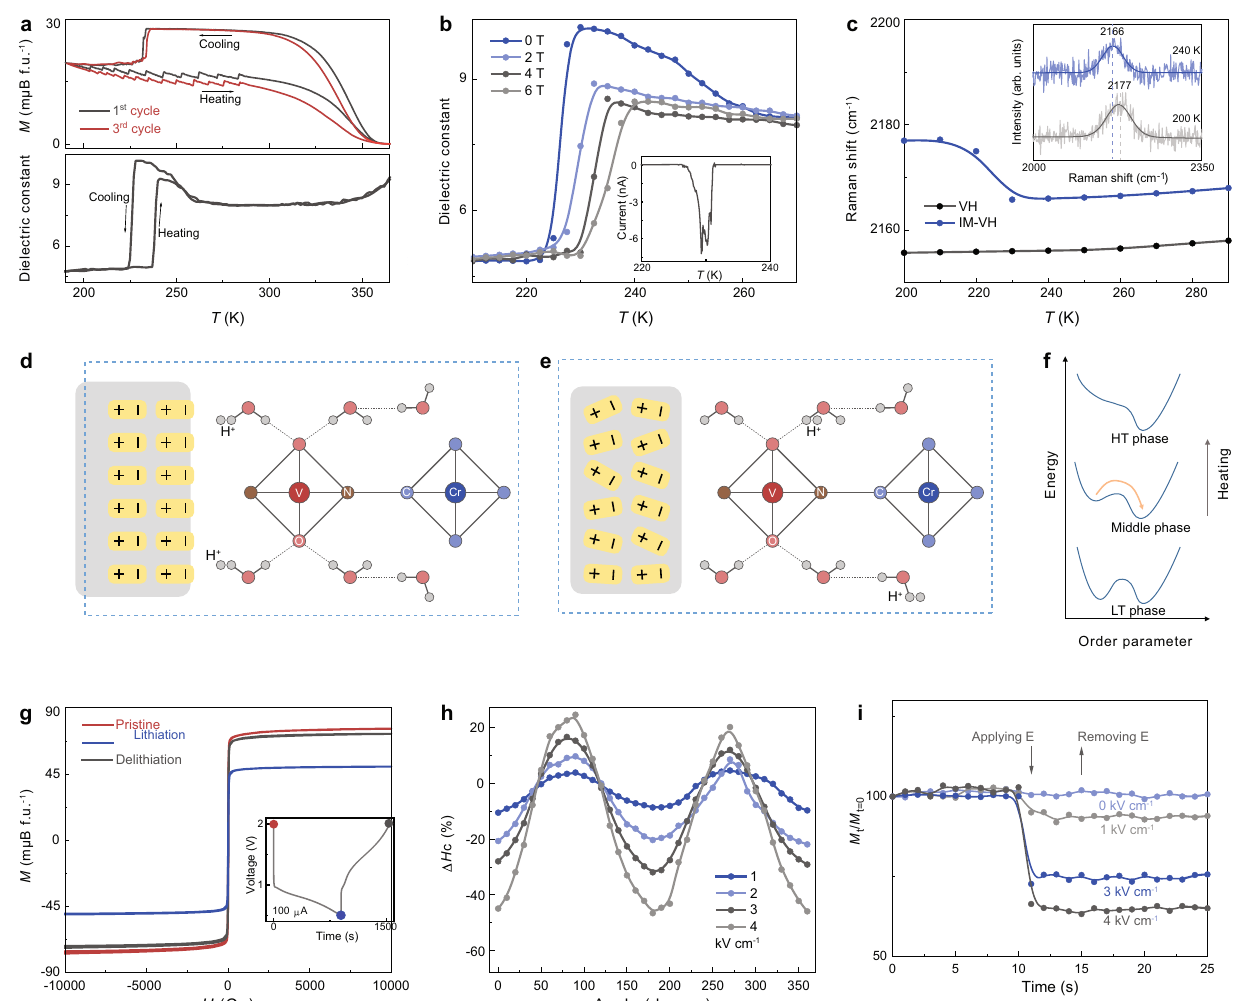
Fig. 4 Proton-mediated ME coupling. a Temperature dependence of magnetization ( M ) at 10 Oe and dielectric constant (1 kHz) for IM-VH. b Temperature dependence of dielectric constant (1 kHz) at different magnetic fi elds for IM-VH. The inset shows the measured pyroelectric current during the cooling process. c Temperature dependence of Raman shift for IM-VH. The inset shows the Raman spectra for IM-VH at 200 and 240 K, the smooth lines are fi tting results. d – f Schematic diagrams for proton-mediated strong coupling between dipole of IM and magnetism of VH. g Lithium-ion battery control of magnetism of VH. Inset shows the lithiation and delithiation process. h Room-temperature angle dependence of coercivity change for IM-VH solid at different electric fi elds. 0° means that the applied electric fi eld is parallel to the magnetic fi eld. The x-axis shows the angle value between the applied magnetic fi eld and the magnetic fi eld direction. i Room-temperature electric fi eld control of magnetism for IM-VH. The sample was fi rst magnetized at 1 T and then the magnetic fi eld was removed. The electric fi eld was applied along the magnetization direction and the remnant magnetization was monitoring in real time. The switching was found to persist after removing the electric fi